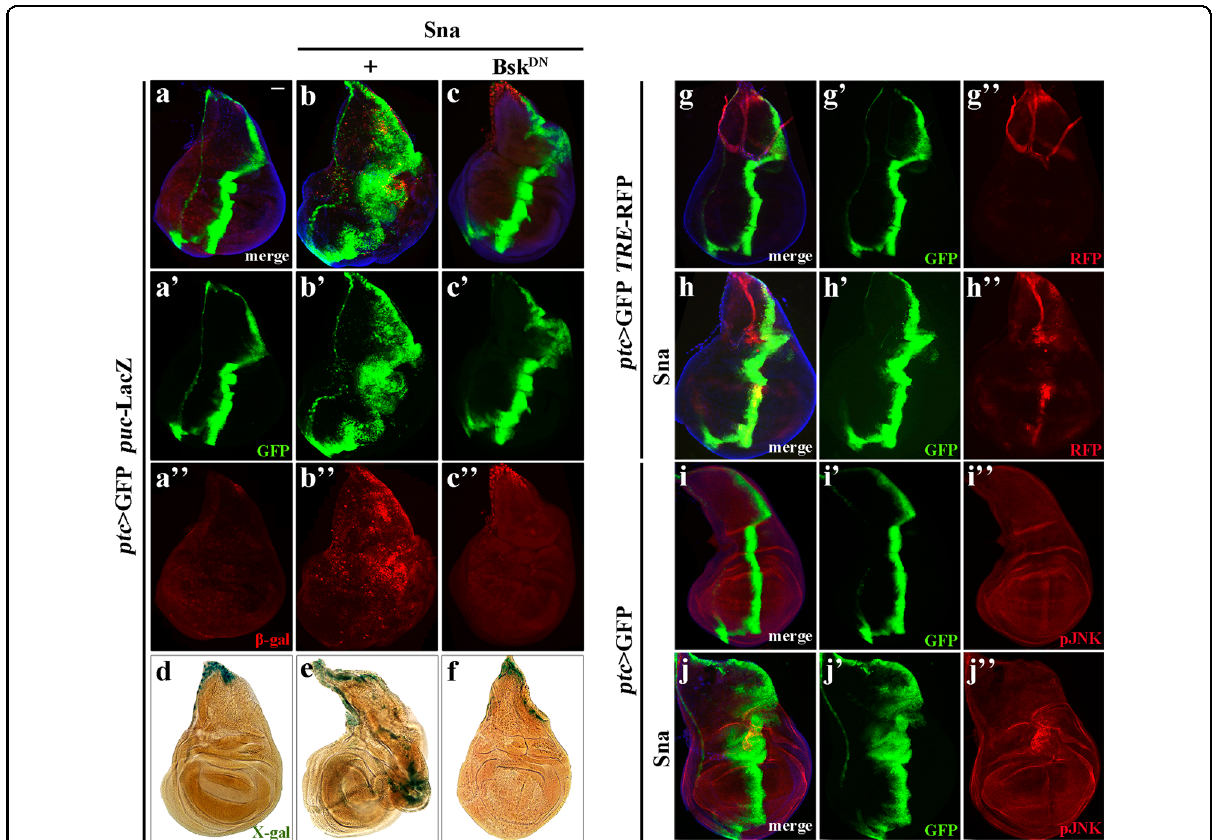
Fig. 7 Sna activates JNK signaling in vivo. a – c and g – j Merged fl uorescence micrographs of Drosophila third-instar larval wing disks are shown. The individual channels detecting only GFP (green, a ’ – c ’ and g ’ – j ’ ), β -gal (red, a ” – c ” ), RFP ( g ” , h ” ), or pJNK signal (red, i ” – j ” ). ( d – f ) Light micrographs showing X-gal staining of the puc -LacZ reporter in wing disks. Compared with the controls ( a , d , g and i ), ectopic expression of Sna elevated the expression of puc -LacZ ( b , e ), TRE -RFP ( h ), and JNK phosphorylation ( j ). The increased puc transcription triggered by ptc > Sna is largely impeded by expressing Bsk DN ( c , f ). See the electronic supplementary material for detailed genotype. Scale bar: 40 µm ( a – f